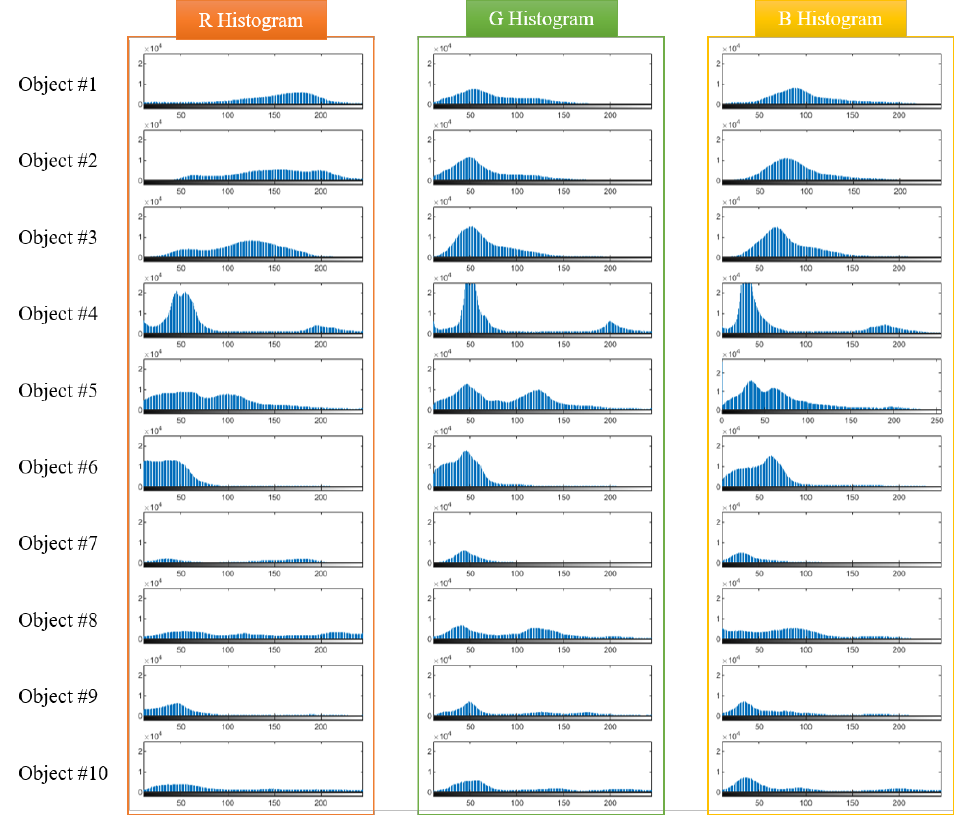
Figure 4. Red, green, and blue (RGB) channel histograms related to images in each